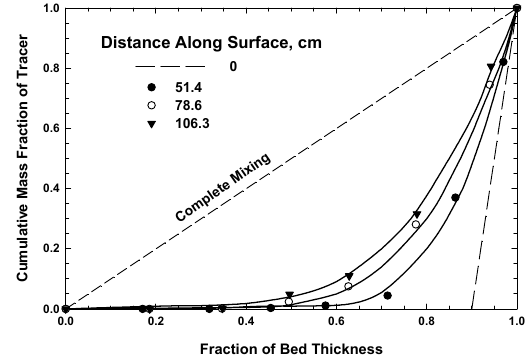
Fig. 5 Mixing of tracer particles during flow over an inclined surface. Tracer fed as a thin layer at the bottom of the steam. Points are experimental; lines are calculated based on Equation 6. Data of Hwang 58) .